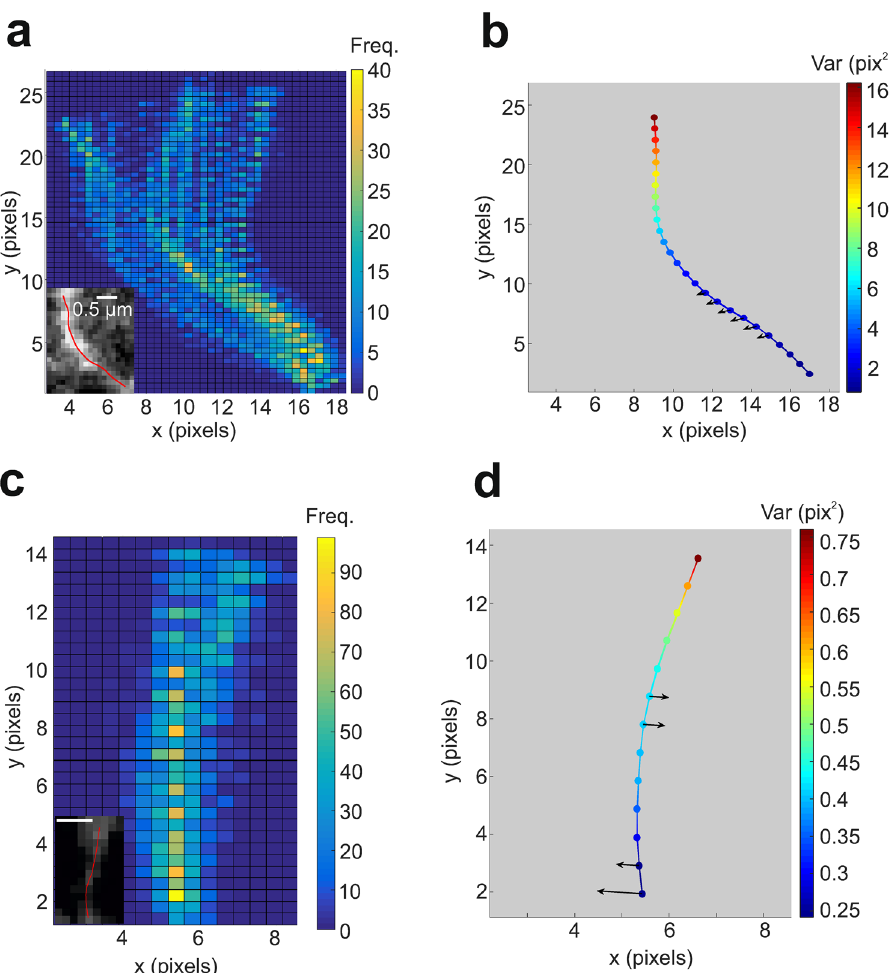
Figure 3. Tracked contours of ER tubules show indications of active motion. ( a , c ) Contours are overlaid to show the time-dependence of tubule shape (inset shows fluorescence image of tracked tubule). More frequently occupied positions are coloured in yellow. ( b , d ) Mean position of tubules in ( a ) and ( c ) respectively, coloured according to the variance of transverse oscillations. Arrows show direction and magnitude of significant transverse skewness, if